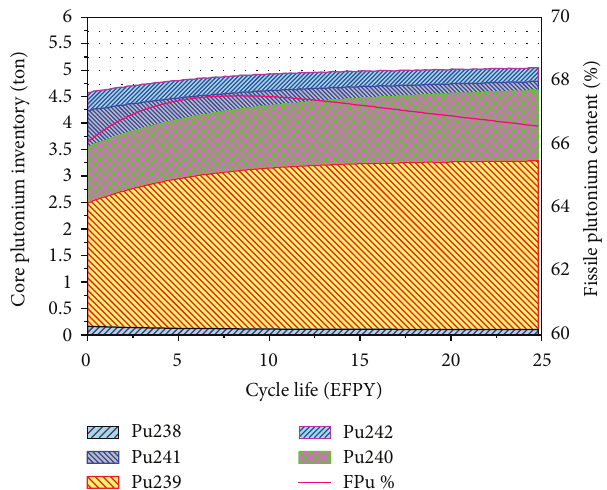
Figure 23: Core plutonium inventory and fissile plutonium fraction versus cycle